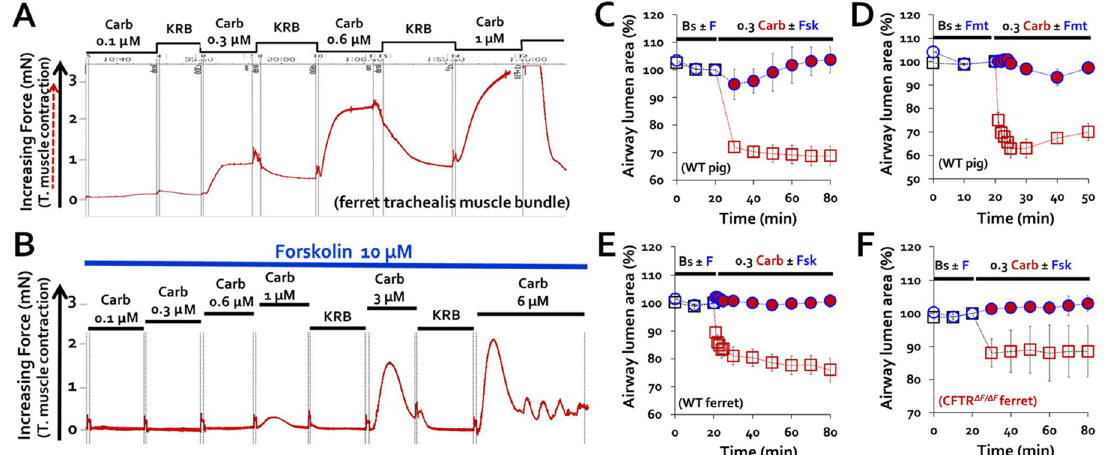
Figure 2. Elevating cAMP inhibited muscle tension and airway narrowing to carbachol. ( A , B ) To measure muscle tension, one end of an isolated WT ferret trachealis muscle bundle was secured in a Sylgard-lined Petri dish filled with KRB solution and the other end was attached by 26-gauge wire to a previously calibrated strain gauge. Tension responses to increasing carbachol doses in the absence ( A ) and presence ( B ) of 10 µM forskolin are displayed. ( C–F ) To measure airway narrowing, thin slices (~ 2 mm) of tracheal rings from WT pigs and WT or CF ferrets were treated with carbachol alone or in the presence of forskolin (F or Fsk) or formoterol (Fmt); their lumens were imaged over time and the areas measured as an assay for muscle constriction. After a baseline period (black open squares), carbachol was added (0.3 µM, red open squares), or in the presence of 10 µM forskolin or formoterol. (red closed circles). Averaged responses at 10 min intervals are shown for: ( C ) WT piglet tracheas (n = 3–7) with forskolin. ( D ) WT piglet tracheas with formoterol (n = 5). ( E ) WT ferret tracheas (2 tracheas, 5 experiments). ( F ). CF ferrets (n = 2, one CFTR ∆F/∆F and one CFTR ∆F/G551D )